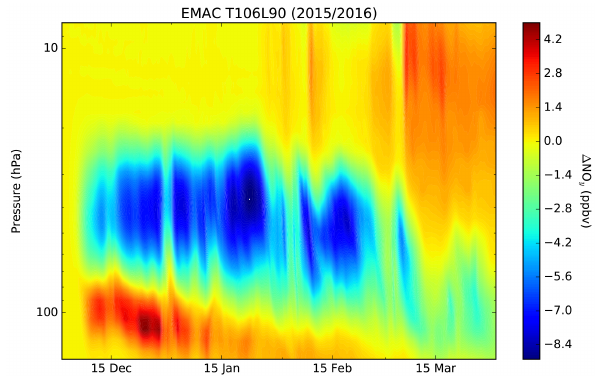
Figure 4. Redistribution of NO y ( (cid:49) NO y ) simulated with EMAC T106L90 (difference of NO y and the passive tracer NO ∗ y ( (cid:49) NO y = NO y − NO ∗ y , averaged over 70–90 ◦